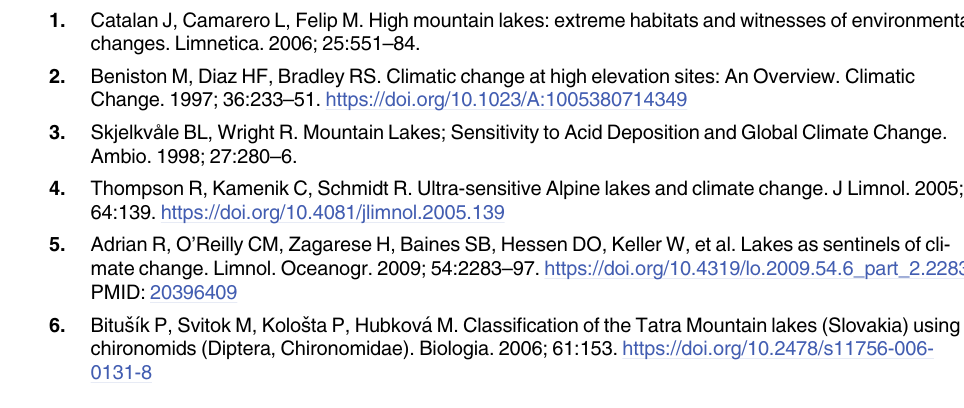
S1 Data. Table of lowest determined taxa and their abundances of all sampled